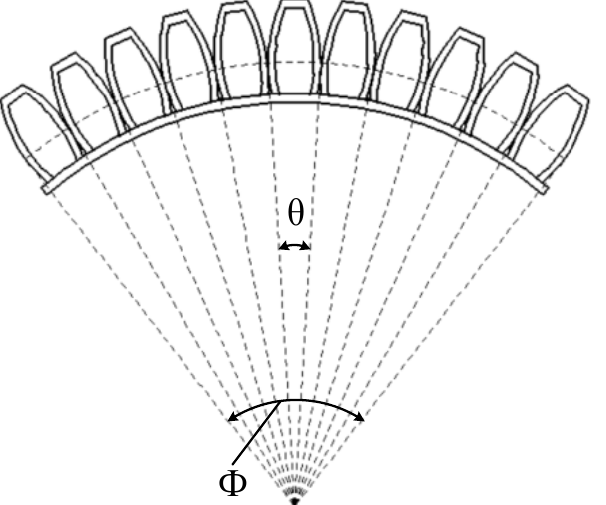
Figure 4. Equivalent model diagram of bending deformation of hexagonal prism soft-bodied bionic actuator. The structural parameters of hexagonal prism soft-bodied bionic actuator are shown in Figure 5, where l 1 is the thickness of airbag expansion wall, l 2 , w 2 and h 2 are the length, width, and height of airbag respectively, h 1 and w 1 are the thickness of airbag top wall and sidewall respectively, h 4 and w 3 are the width and height of cavity airway. l is the length of a regular hexagonal prism, a is side length, and r is the radius of a hollow cylinder.